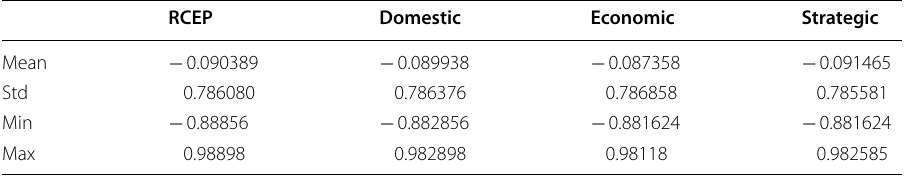
Table 2 Overall sentiment score #RCEP RCEP Domestic Economic Strategic Mean −